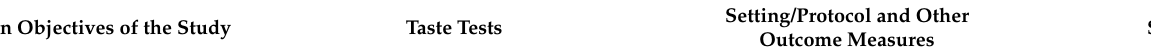
Table 2. Observational studies included in the